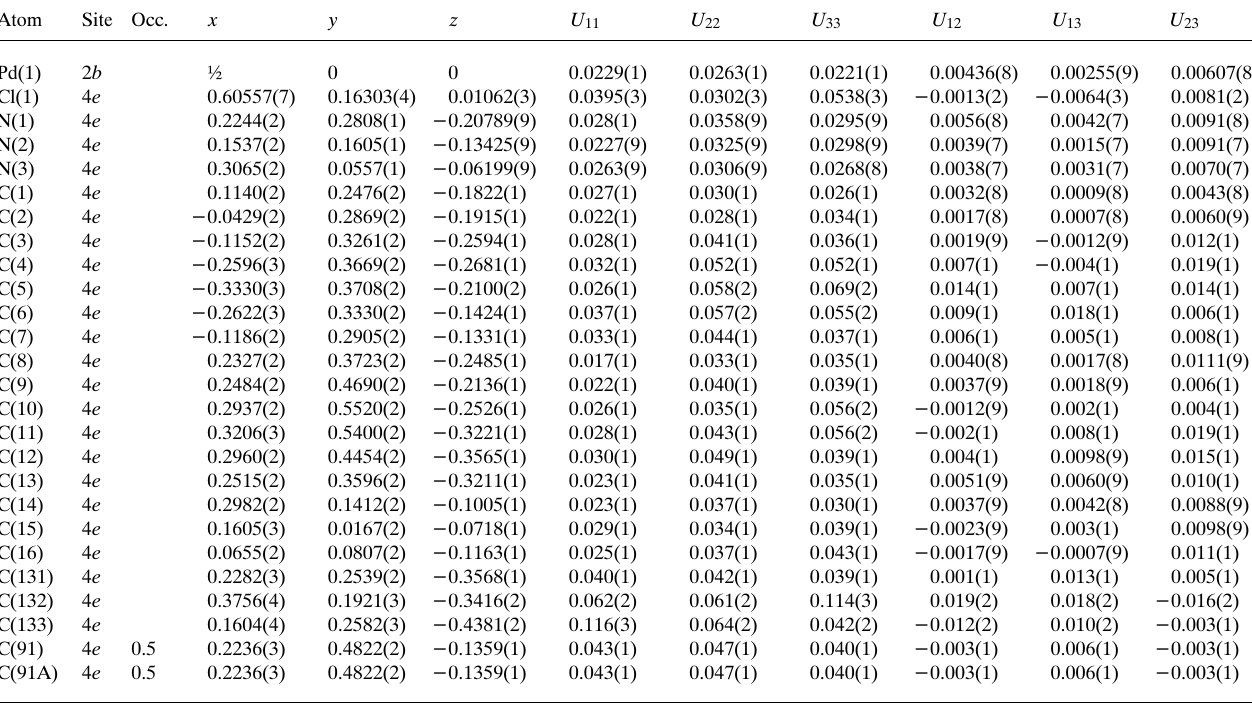
Table 3. Atomic coordinates and displacement parameters (in Å 2 ) .